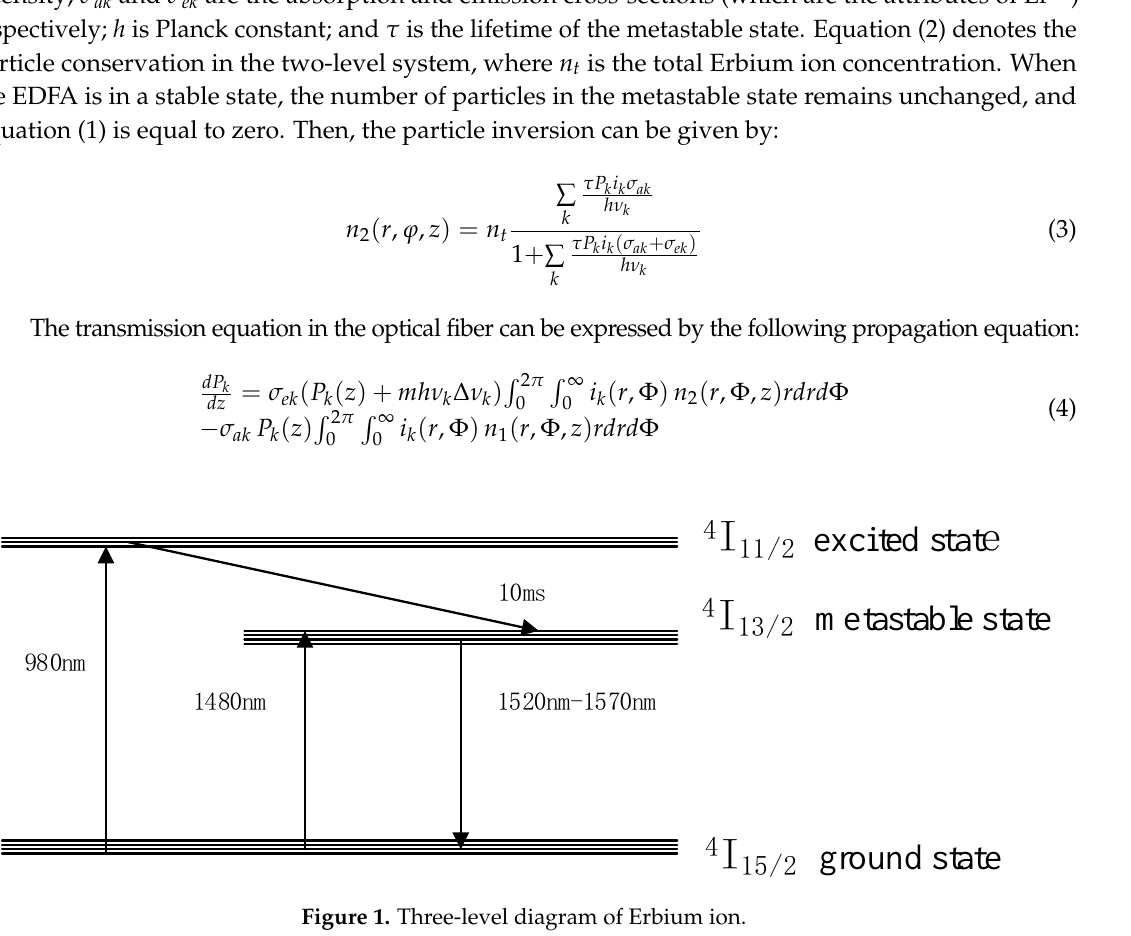
Figure 1. Three-level diagram of Erbium ion.